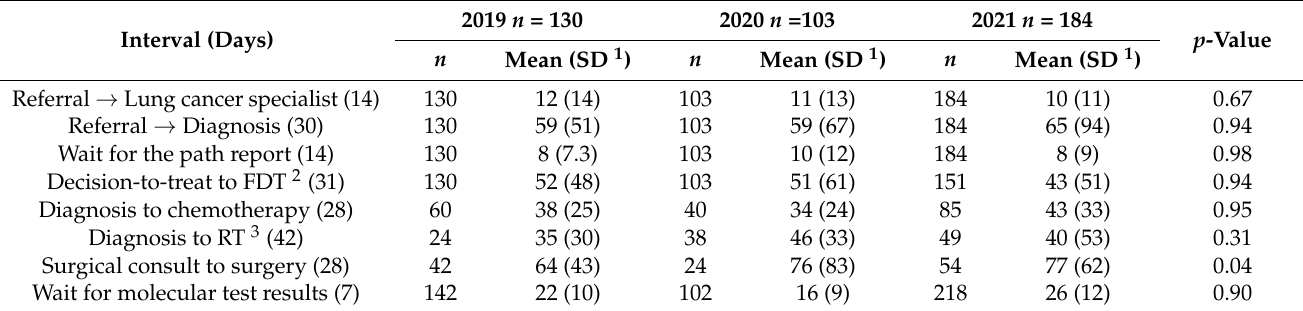
Table 6. Mean wait times before and during two years of the COVID-19 pandemic.